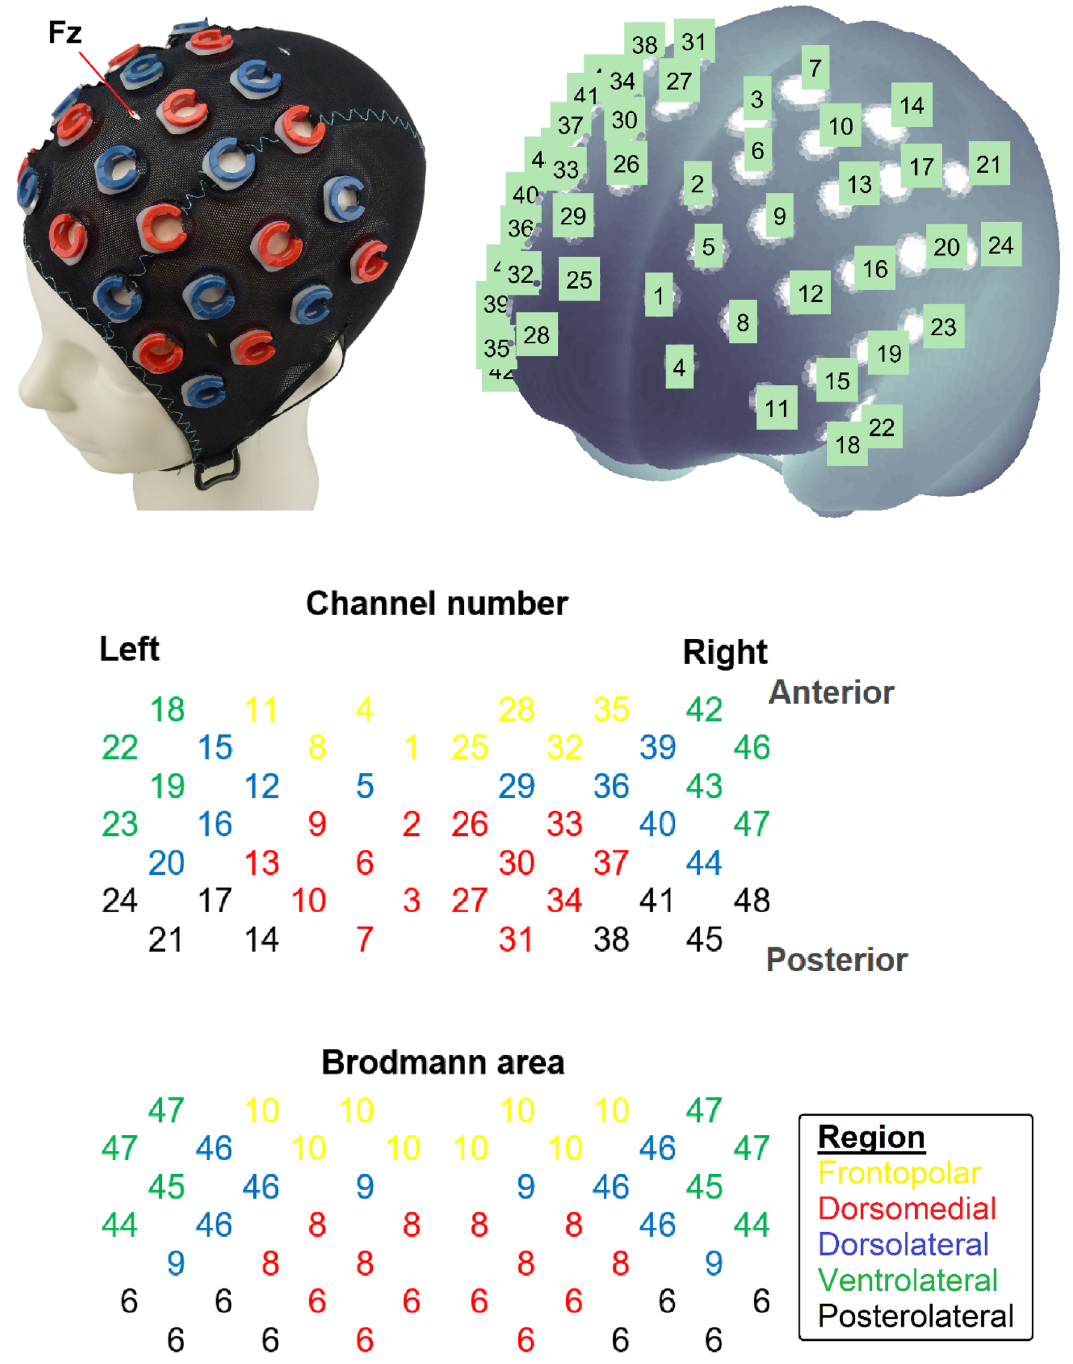
Figure 2. Setup of the functional near-infrared spectroscopy measurement. Note This figure was adapted from Yeung 49